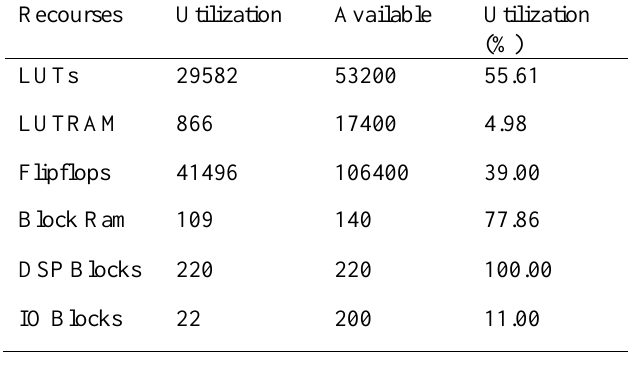
Resource usage of the proposed hardware on Xilinx ZYNQ